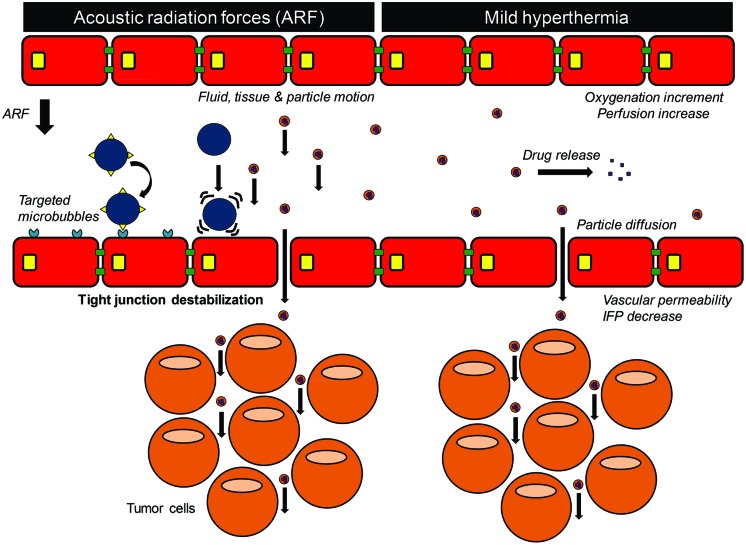
Acoustic radiation forces and ultrasound-induced hyperthermia.